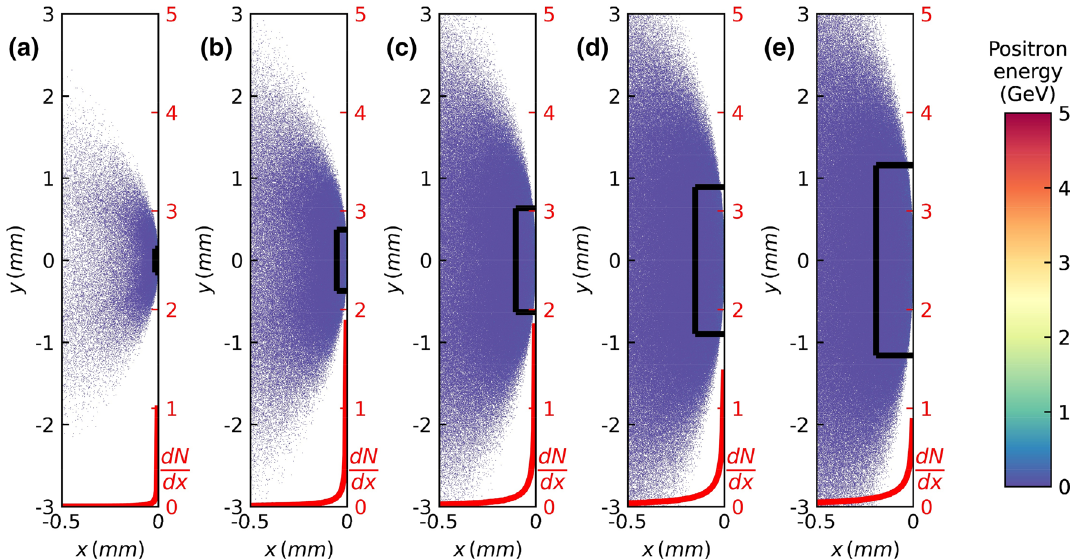
Figure 3. Longitudinal distribution of generated positrons for various lead converter thicknesses. The color code and the definition of the positron beam size (rectangular box in each figure) are identical to those in Fig. 1b. The driver electron energy is 5 GeV, and the lead converter thicknesses are ( a ) 1 L rad , ( b ) 2 L rad , ( c ) 3 L rad , ( d ) 4 L rad , and ( e ) 5 L rad . The red curves represent the number densities of positrons along the x -axis normalized by the peak value in ( a